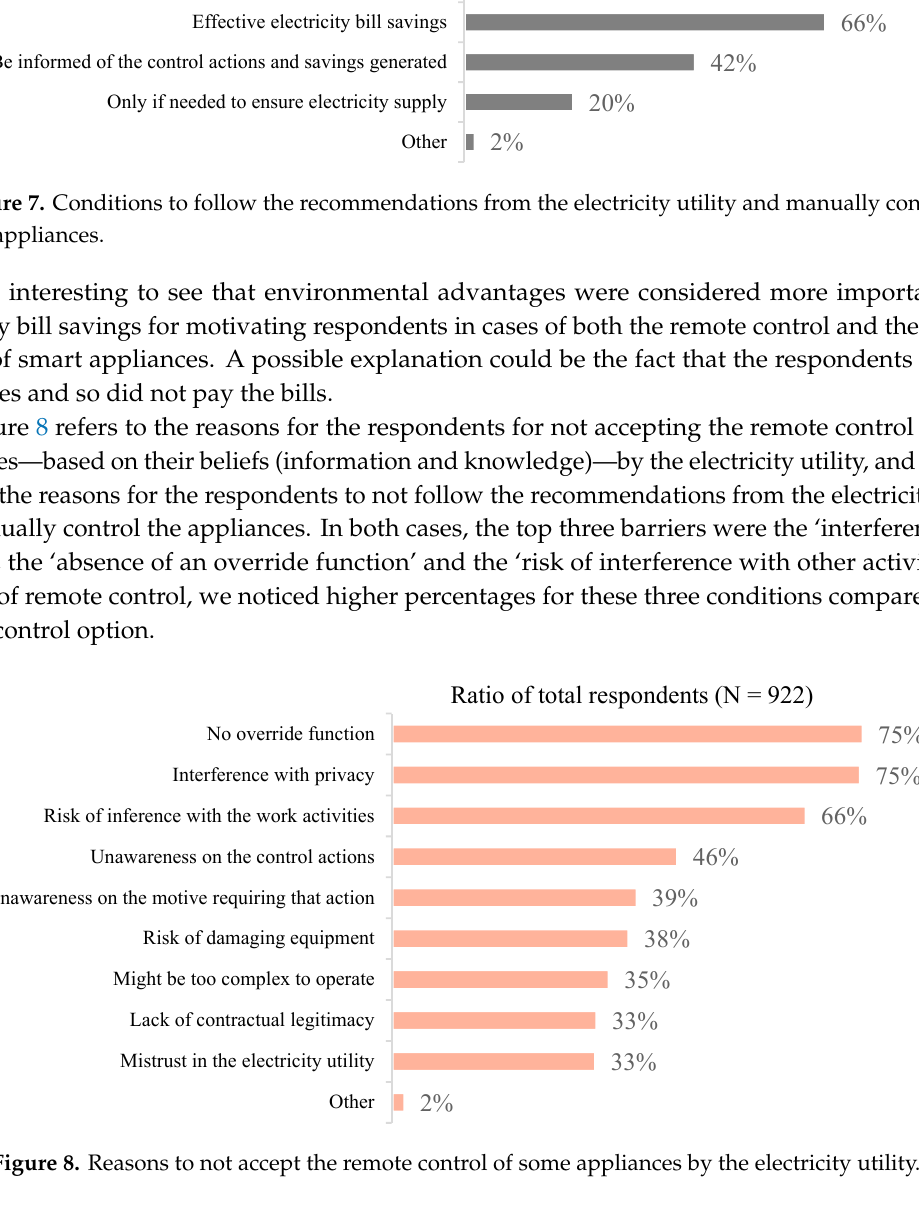
Figure 9. Reasons to not follow the recommendations from the electricity utility and manually control the appliances. Thus, the results related to the motivation to accept a flexible energy usage showed that the privacy was judged as really important by the case study office’s occupants and could represent a relevant barrier for the adoption of smart controls and smart appliances. Conversely, the interference with privacy did not seem to have much impact for Dutch residents in the study of [34]. Moreover, in contrast to the results arisen for the willingness to use smart appliances in the office (Section 3.4), the ‘absence of an override function’ was perceived as an obstacle and it implies that office occupants’ respondents were not ready to completely accept whichever control and that they wanted to always be able to override the operation according to their personal preferences. To understand the respondents’ preferences to accept a flexible energy usage, a list of motivating information was provided using a Likert scale with from ‘1-not motivated at all’ to ‘5-really motivated’ as choices. The results are shown in Figure 10. The top three preferences were ‘seeing how much money you are saving’ (45.8% stated preference ‘5-really motivated’), ‘seeing how much you are minimizing your electricity usage’ (45.3% stated preference ‘5-really motivated’) and ‘seeing how sustainable you are’ (38.6% stated preference ‘5-really motivated’). The option ‘seeing how you are doing compared to your colleagues’ resulted as the least interesting for most of the respondents